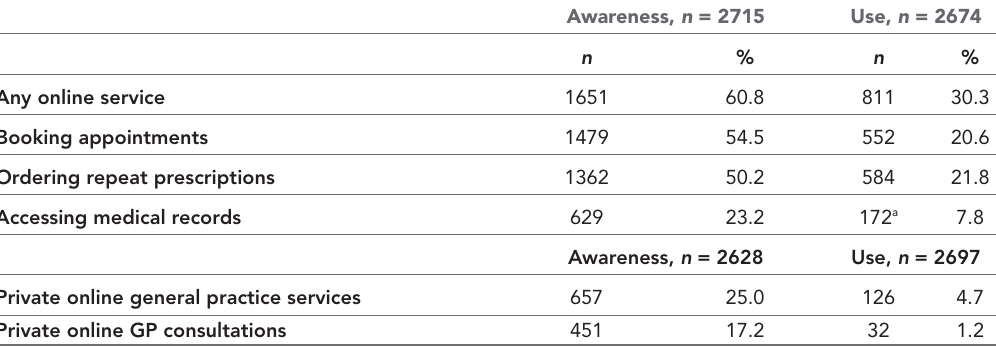
Table 3 Awareness and use of online